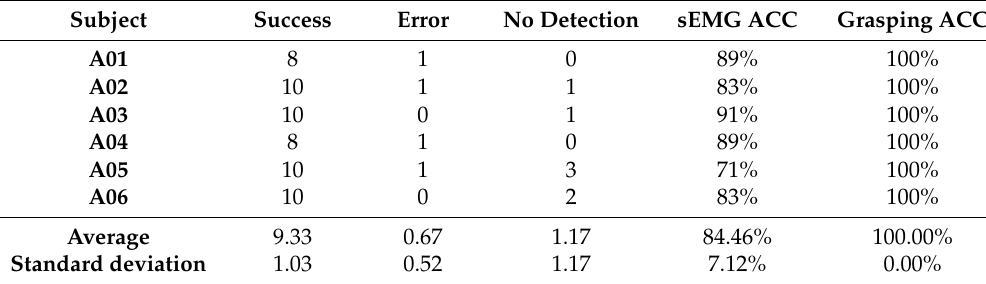
Table 2. sEMG performance and grasping accuracy for object position 2.